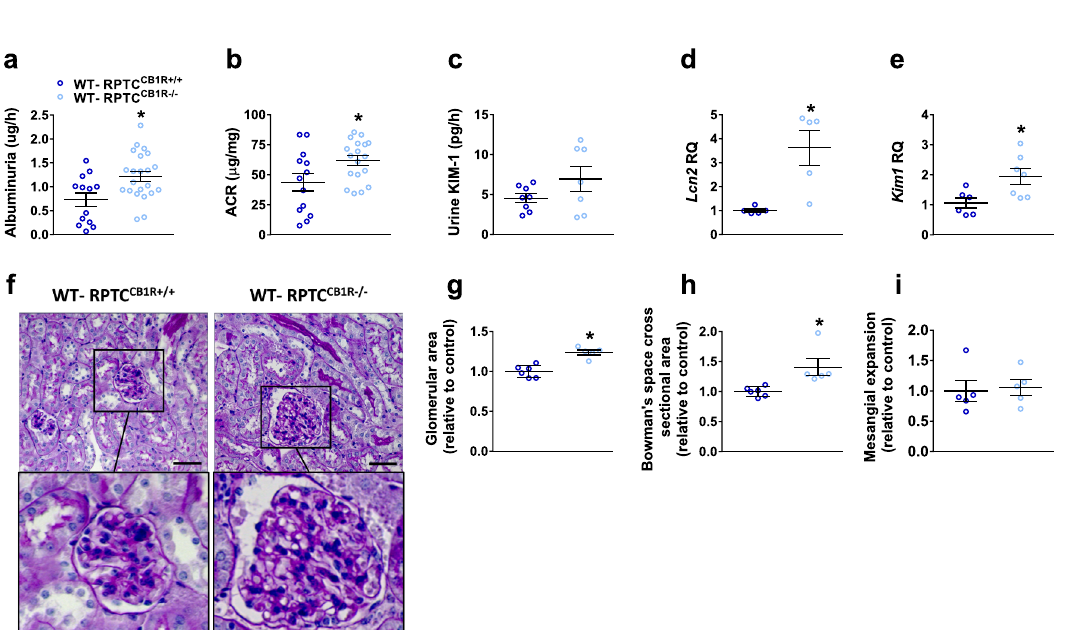
Fig. 6 mTORC1 overactivation in RPTC-CB 1 R KO mice promotes kidney functional and morphological abnormalities. a Albuminuria in 16-week-old normoglycemic mice. n = 13 mice for WT-RPTC CB1R + / + , n = 22 mice for WT-RPTC CB1R − / − (* P = 0.0079). b Urine albumin-to-creatinine ratio (ACR) in 16-week-old normoglycemic mice. n = 13 mice for WT-RPTC CB1R + / + , n = 18 mice for WT-RPTC CB1R − / − (* P = 0.0301). c Urinary KIM-1 levels in 16-week-old normoglycemic mice. n = 8 mice for WT-RPTC CB1R + / + , n = 7 mice for WT-RPTC CB1R − / − . d qPCR analysis of the kidney injury marker, Lcn2 . n = 5 mice per group (* P = 0.0070). e qPCR analysis of the kidney injury marker, Kim1 . n = 6 mice for WT-RPTC CB1R + / + , n = 7 mice for WT- RPTC CB1R − / − (* P = 0.0197). f Representative PAS staining of the kidney, 40× magni fi cation, scale bar: 50 µ m. g Glomerular area quanti fi cation (at least 10 glomeruli per mouse). n = 6 mice for WT-RPTC CB1R + / + , n = 5 mice for WT-RPTC CB1R − / − (* P = 0.0142). i Mesangial expansion quanti fi cation (at least 10 glomeruli per mouse). n = 6 mice for WT-RPTC CB1R + / + , n = 5 mice for WT-RPTC CB1R − / − . Data represent the mean ± SEM and were analyzed by Unpaired Two-tailed Student ’ s t-test. * P < 0.05 relative to the corresponding control groups. Source data are provided as a Source Data fi